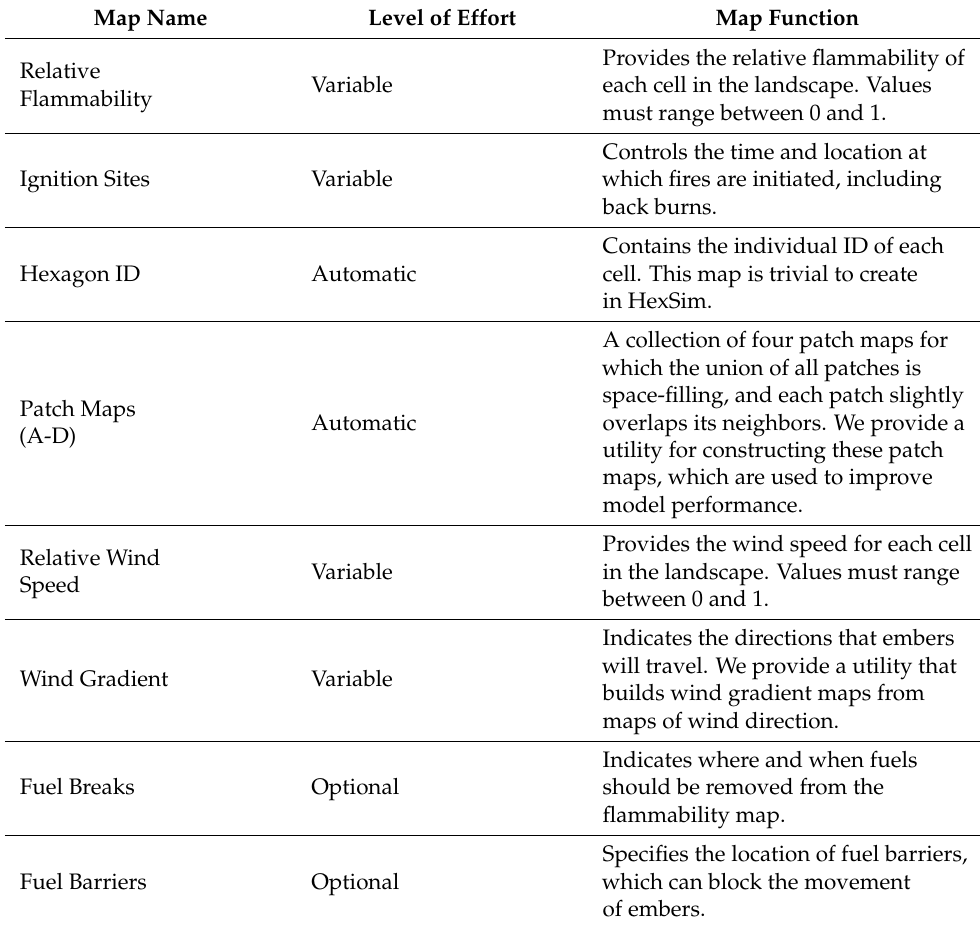
Table 2. Input maps used by the HexFire model. Variable suggests that map construction effort will range from minimal to significant, depending on study design. Automatic implies that a method or utility is available to construct the map. Optional indicates that a map may be left